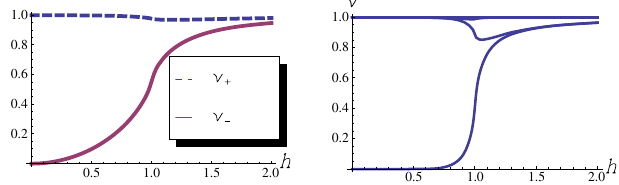
obtained from the j FIG. 4. Left: Plot of the first few eigenvalues of ρ infinite size block, as a function of h . The eigenvalues ’ multi- (cid:2) plicities are not shown. (For instance, the highest eigenvalue is doubly degenerate for h < 1 and unique for h > 1 ; see Ref. [44].) Right: Plot of the derivative of the Rényi entropy with respect to the magnetic field h , as a function of α , for two different values of h in the ferromagnetic